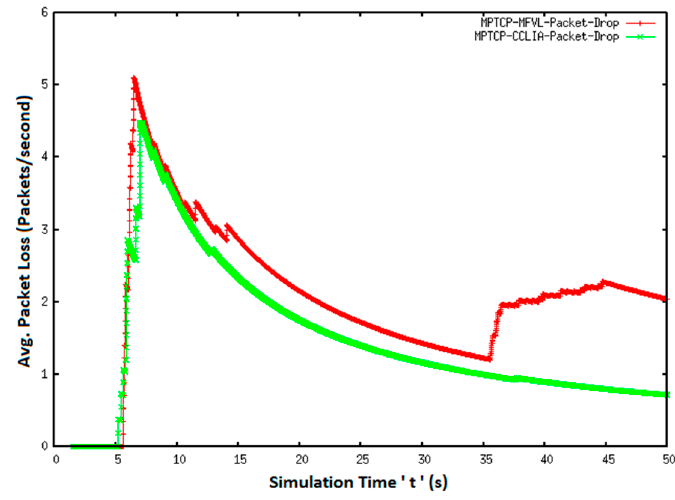
Figure 11. Average packet loss rate of Setup 2.